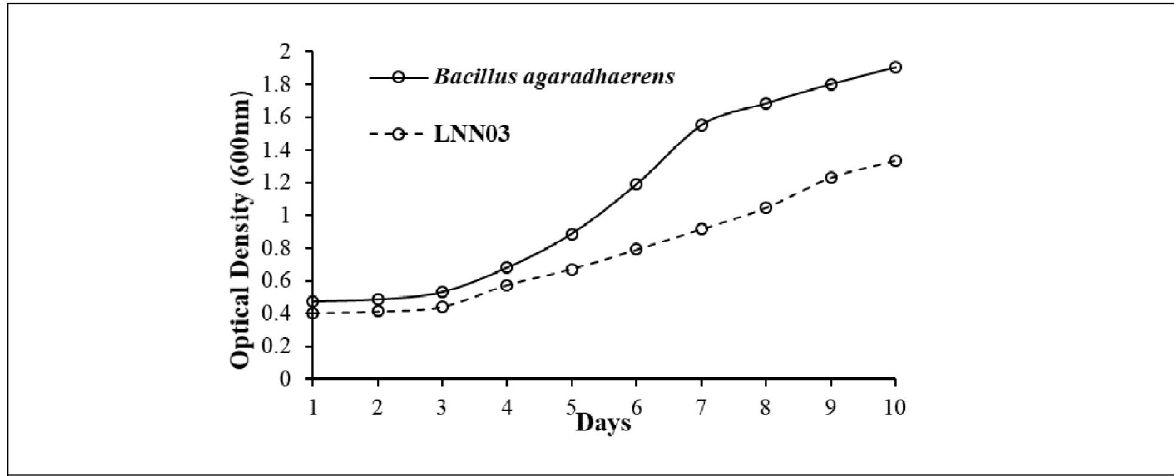
Figure 2: Growth pattern of Bacillus agaradherens (LNC06) and LNN03 on chicken feather weight during the period of experiment. At the beginning of the experiment, LNN03 degraded the feathers faster from 0.107 g to 0.059 g in day 4 (Figure 3). Bacillus agaradhaerens (LNC06) picked up the degeneration pace from day 4 to day 10 (0.069 g to 0.013 g). Ultimately, Bacillus agaradhaerens (LNC06) performed better in the experiment.